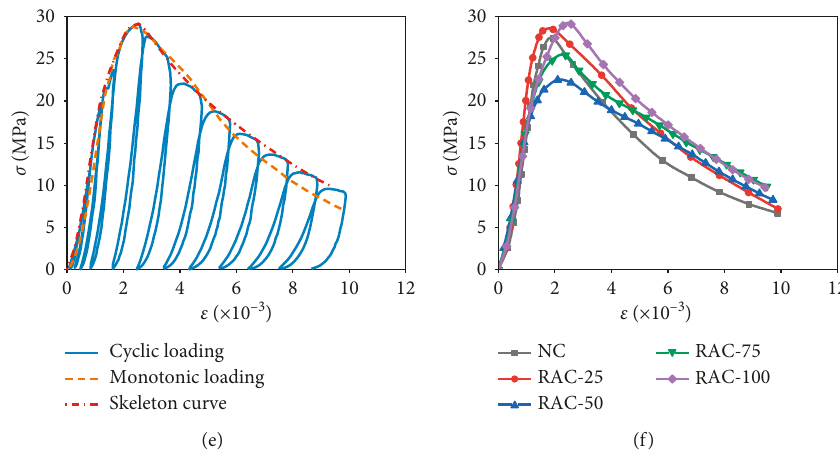
Figure 10: Stress-strain curves of the RAC. (a) NAC. (b) RAC-25. (c) RAC-50. (d) RAC-75. (e) RAC-100. (f) Skeleton